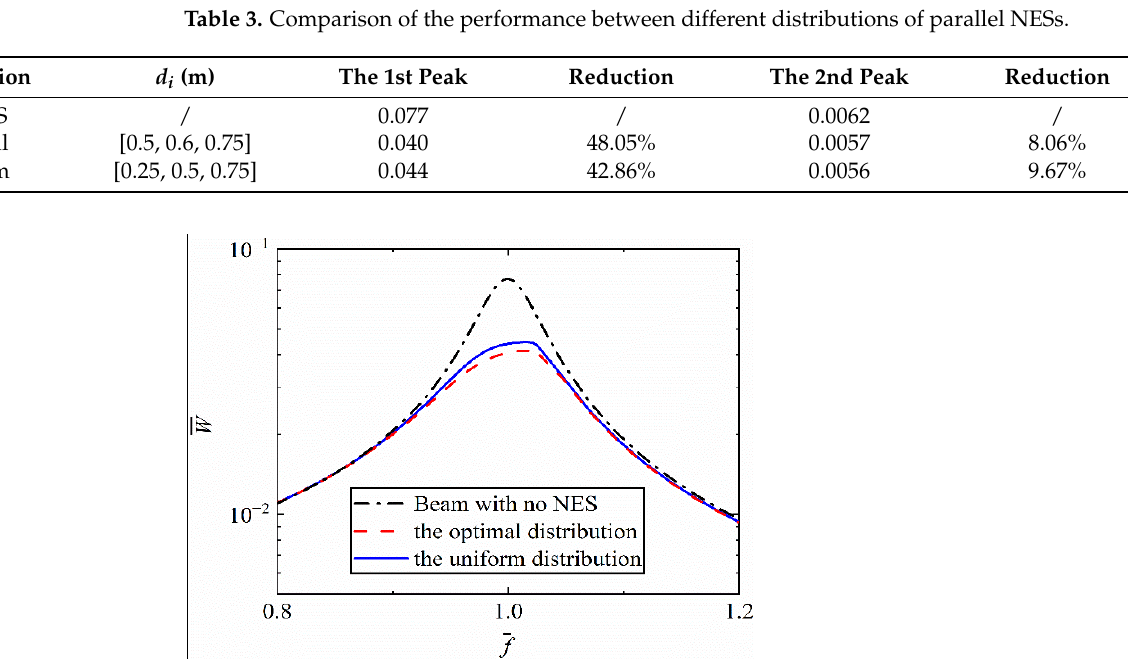
Figure 8. Comparison of the performance between the optimal distribution and the uniform distribution.